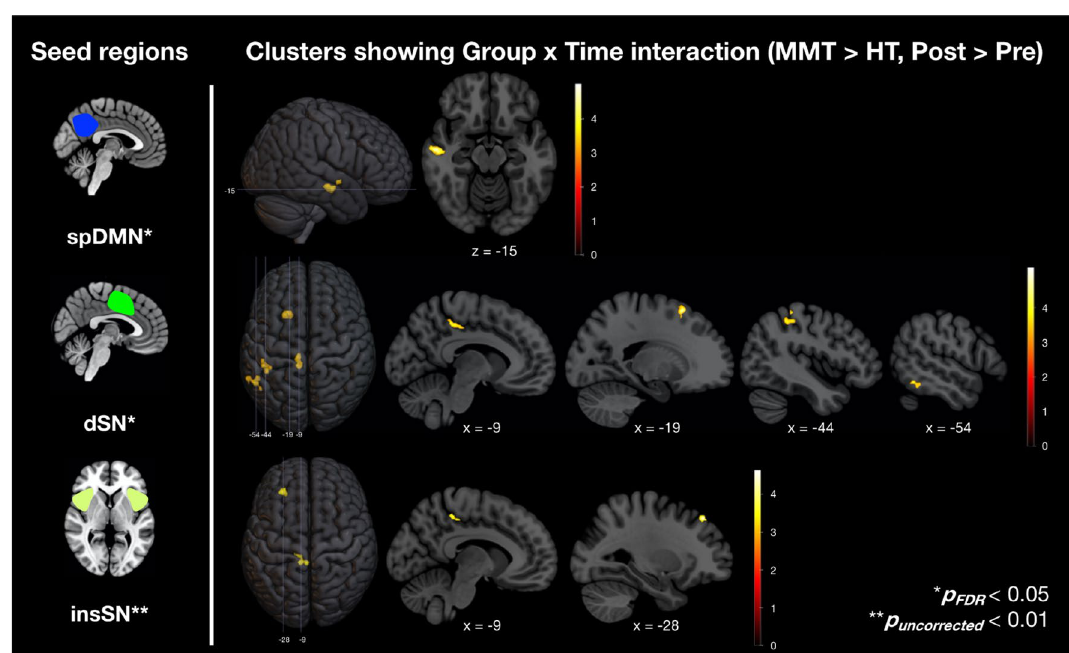
Figure 4. Seed region and the clusters showing group by time interactions as displayed on a Montreal Neurological Institute template taken from ICBM 152 Nonlinear atlases version 2009 (© 1993–2004 Louis Collins, McConnell Brain Imaging Centre, Montreal Neurological Institute, McGill University) 43 . Visualized with help of MRIcroGL v1.2.20210317 (https:// www. nitrc. org/ proje cts/ mricr ogl) 44 . MMT Mindfulness Meditation Training, HT Health Training, spDMN superior posterior default mode network, dSN dorsal salience network, insSN insular salience